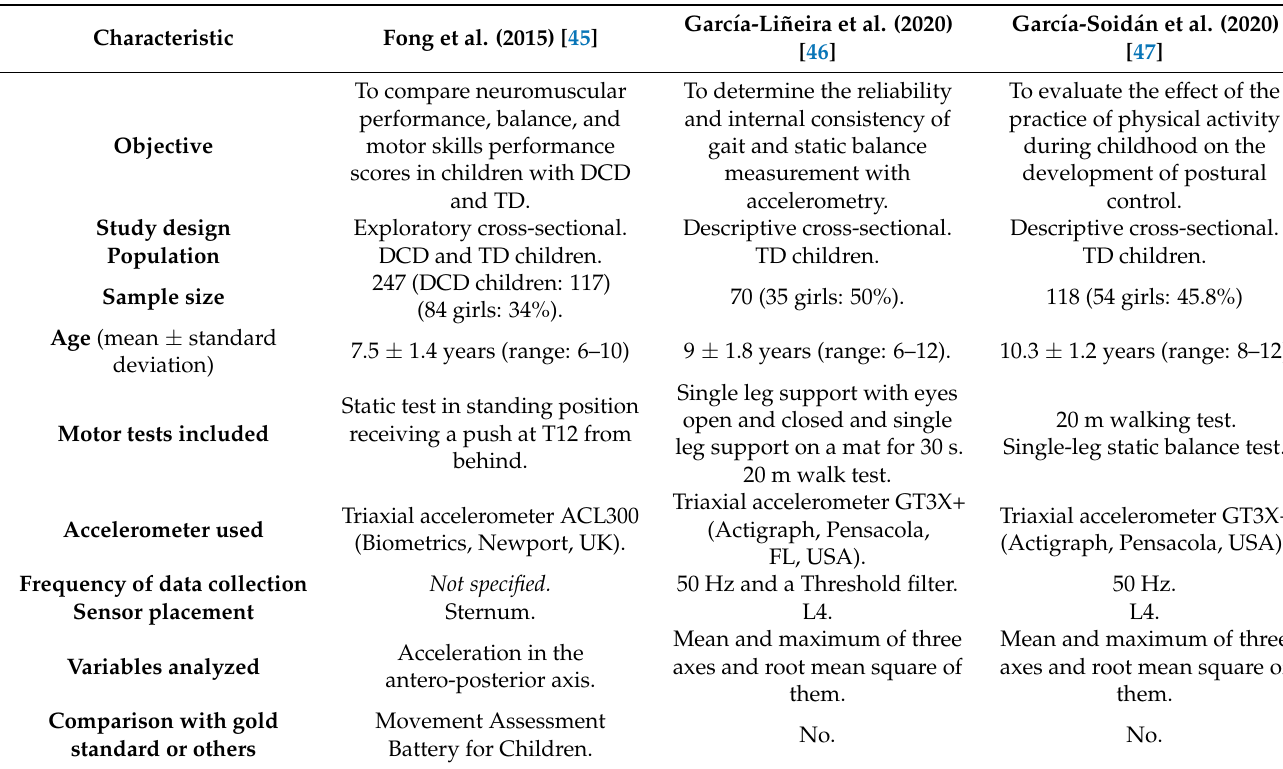
Table 2. Methodological characteristics of the articles reviewed.